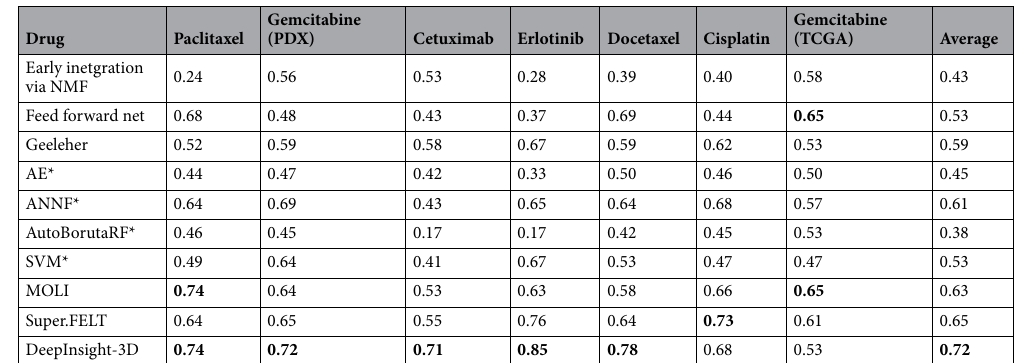
Table 1. A comparison of DeepInsight-3D for drug response prediction with multi-omics profiles using test AUCs. The test samples are the same for all the comparators. The highest results are marked with bold fonts. *These methods are executed on a slightly different test sets (but similar enough for comparison) as reported in the Super.FELT